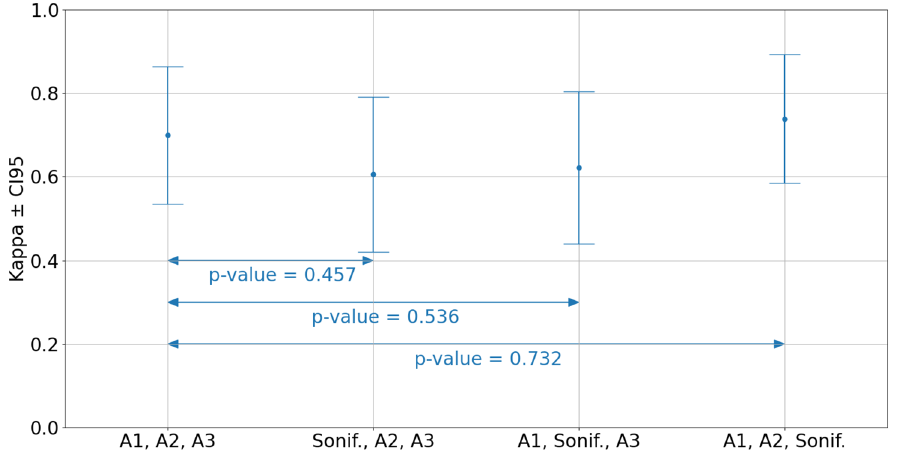
Figure 4. Fleiss kappa while exchanging one annotator by the AI sonification survey results and its